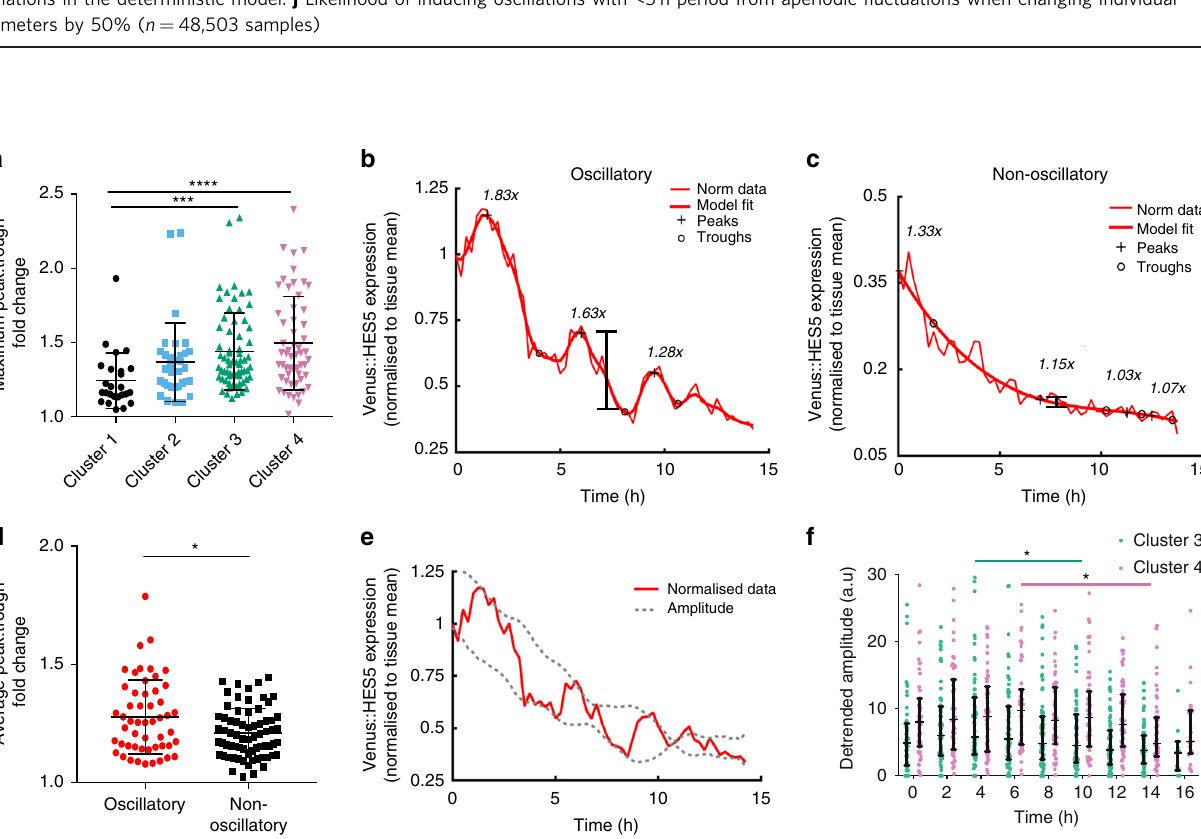
Fig. 6 Hes5 network is poised at aperiodic to oscillatory transition point. a Schematic of stochastic model for transcriptional autorepression of HES5. b Bayesian posterior model predictions of HES5 periods. Periods are extracted from simulated data of 12 h duration using Hilbert transforms. Black line indicates mean of experimentally measured periods. Mean = 4.47 h, SD = 2.51 h, n = 4901 samples. c Distribution of model predicted relative standard deviations (standard deviation/mean) of HES5 expression over time. Mean = 0.078, SD = 0.023, n = 4901 samples. The distribution approaches zero around 0.15, the experimentally determined maximum value of standard deviation of Venus::HES5 over time (de-trended data) in proliferating progenitors in clusters 1 and 2 (Supplementary Fig. 10b). d – f Ten example traces generated using the model are shown at three different parameter points. The power spectrum does not have a dominant non-zero peak in d , whereas the power spectra in e and f do have a dominant non-zero peak with decreasing width from e to f showing increasing coherence. Parameter values are ( d ) α m = 0.64 min − 1 , α p = 17.32 min − 1 , P 0 = 88,288.6, τ = 34 min, n = 5.59, ( e ) α m = 39.93 min − 1 , α p = 21.56 min − 1 , P 0 = 24,201.01, τ = 33 min, n = 4.78, and ( f ) α m = 44.9 min − 1 , α p = 3.13 min − 1 , P 0 = 35,080.2, τ = 40 min, n = 5.62. The half-lives of the protein and mRNA are set to 90 and 30 min, respectively. g Response curves in coherence when changing the protein degradation rate ( n = 4901 samples). The black line is located at the degradation rate corresponding to a 90 min HES5 protein half-life. h , i Heatmaps showing expected coherence for the stochastic model ( h ) and the deterministic model ( i ) of HES5 expression as protein and mRNA degradation rates are changed. The blue dots mark experimentally measured values for the protein and mRNA degradation rates, corresponding to a 90 and 30 min half-life, respectively. Experimentally measured degradation rates are located on the slope of increasing coherence values in the stochastic model, and in a region of no expected oscillations in the deterministic model. j Likelihood of inducing oscillations with <5 h period from aperiodic fl uctuations when changing individual parameters by 50% ( n = 48,503 samples)